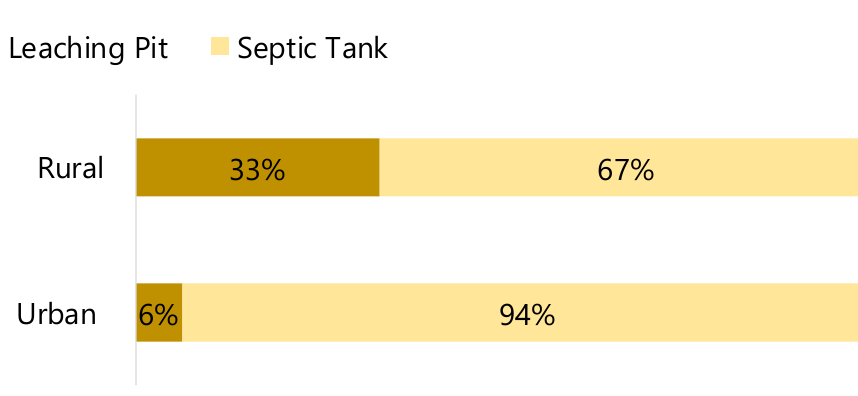
Figure 6. Relative share of different types of on-site sanitation systems